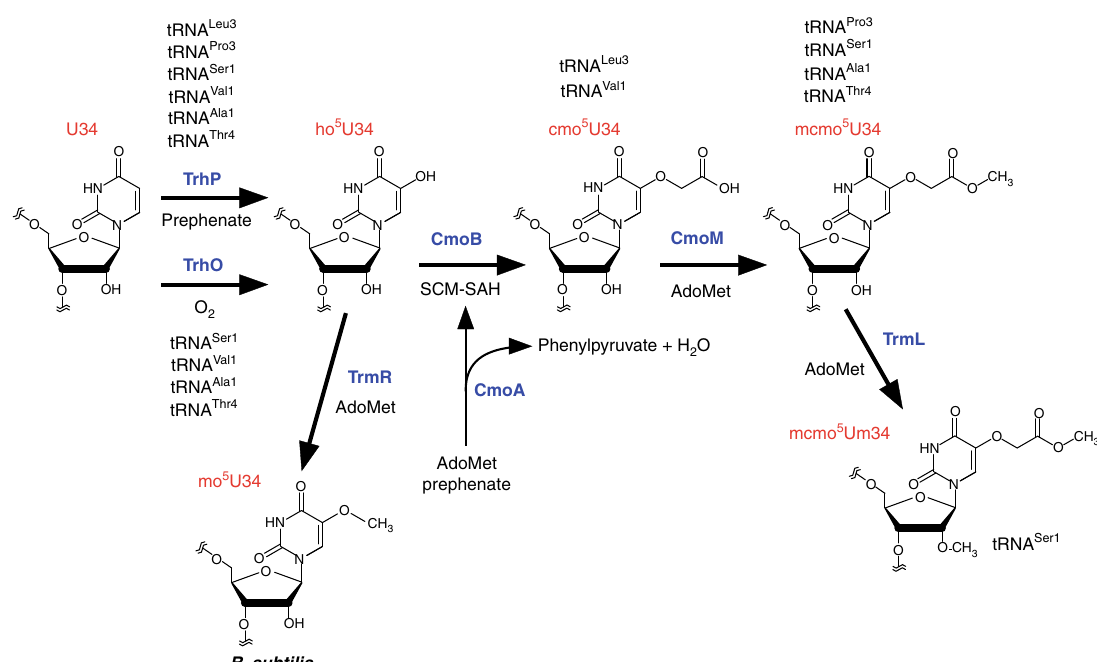
Fig. 7 Biogenesis of mcmo 5 U34 and derivatives. At the fi rst step, U34 is redundantly hydroxylated by independent pathways mediated by TrhP and TrhO to form ho 5 U34 in tRNAs responsible for decoding NYN codons. TrhP requires prephenate as a metabolite for ho 5 U34 formation, whereas TrhO uses O 2 to hydroxylate U34 to form ho 5 U34 under aerobic conditions. CmoA synthesizes SCM-SAH from prephenate and AdoMet. CmoB uses SCM-SAH for carboxymethylation of ho 5 U34 to yield cmo 5 U34. Four tRNAs (for Ala1, Ser1, Pro3, and Thr4) are further methylated by CmoM to yield mcmo 5 U34. In Gram-positive bacteria, including B. subtilis , ho 5 U34 is methylated by TrmR to yield mo 5